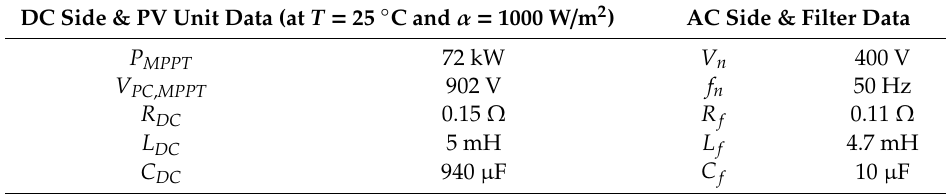
Table 1. System data.